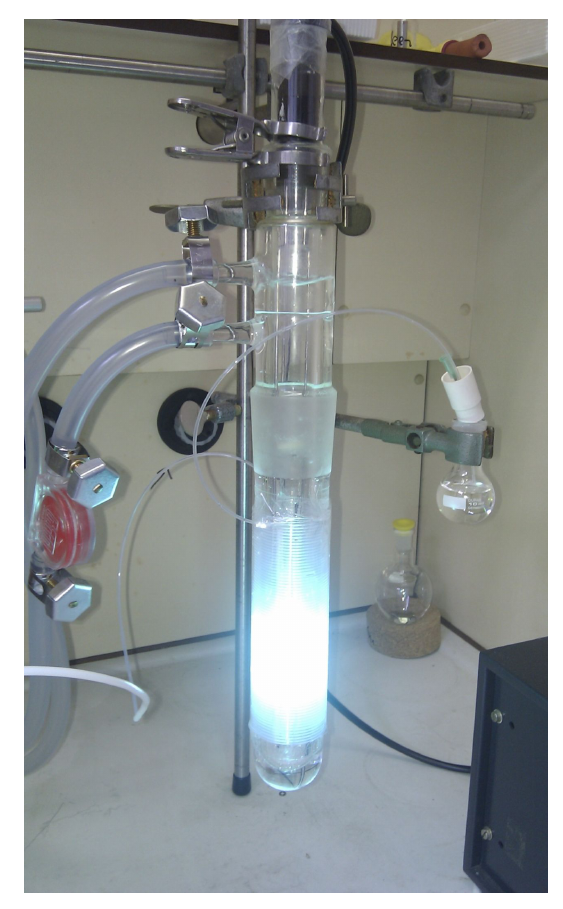
Figure 1: Flow-reactor setup used in the optimization study.